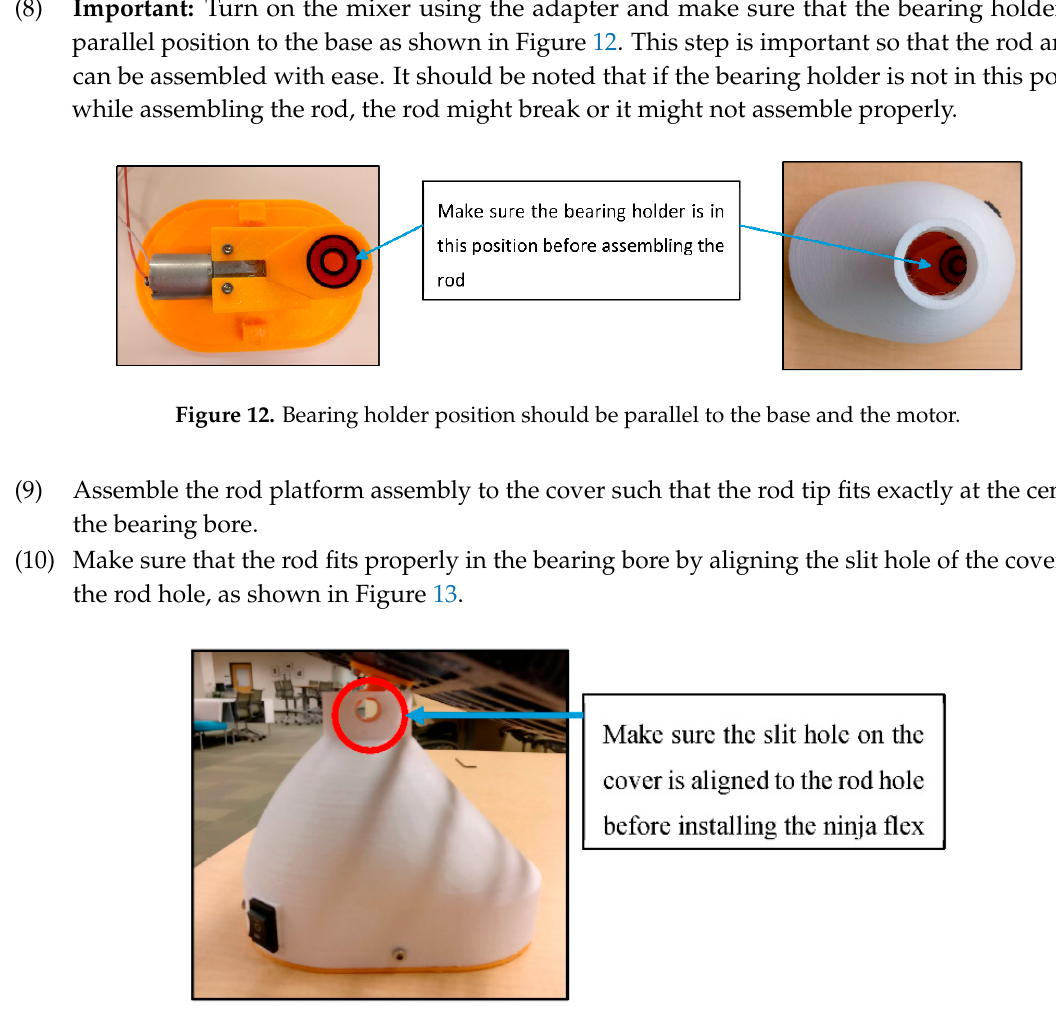
Figure 13. Visual check needed to determine if the rod hole is aligned with the cover holes.